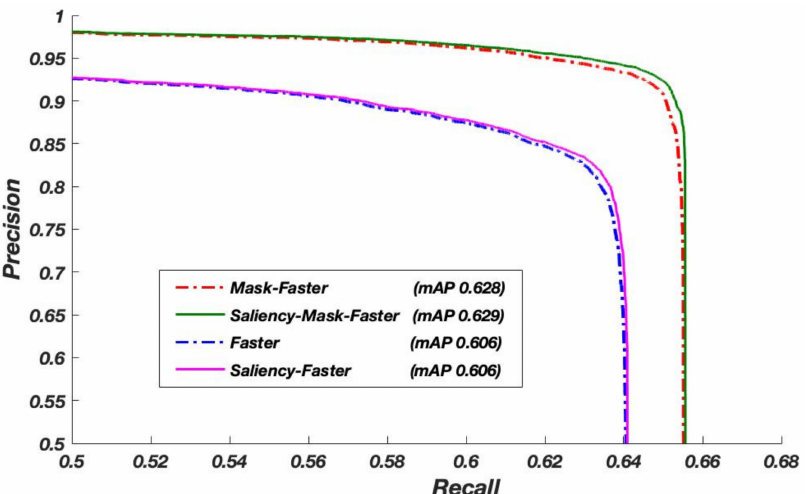
Figure 21. The curves of the precision-recall (PR) of di ff erent methods on the same conditions. The blue dash-dotted line represents the Faster R-CNN, the purple line represents the Saliency-Faster R-CNN, the red dash-dotted line represents the Mask-Faster R-CNN, and the green line represents the cascading